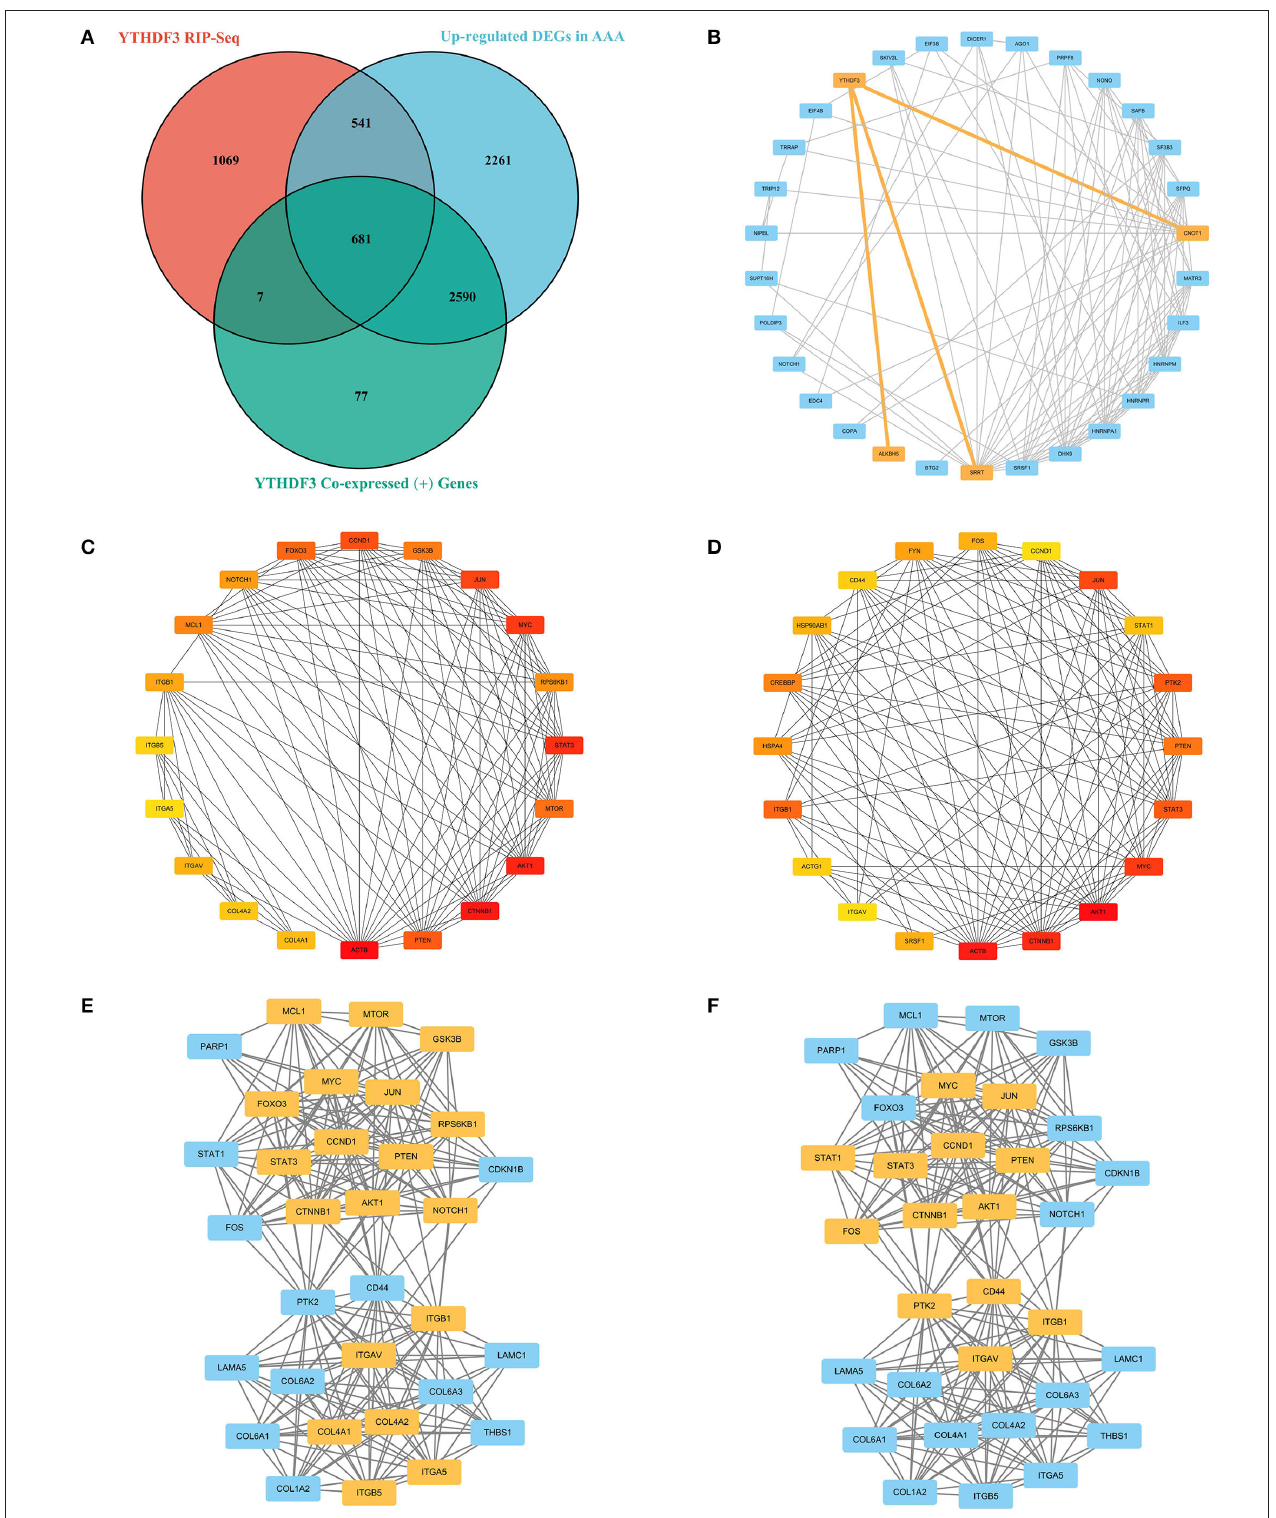
FIGURE 9 | The construction of PPI network based on the RIP-Seq result and the prediction of YTHDF3 downstream targets participating in AAA progression. (A) The Venn diagram showing the overlapping of the AAA-specific YTHDF3 -binding genes YTHDF3 , YTHDF3 co-expressed ( + ) genes and up-regulated DEGs in